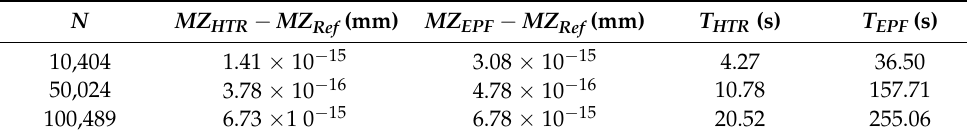
Table 3. Values of MZ-MZ ref and execution time (s) for HTR and EPF (configuration II).